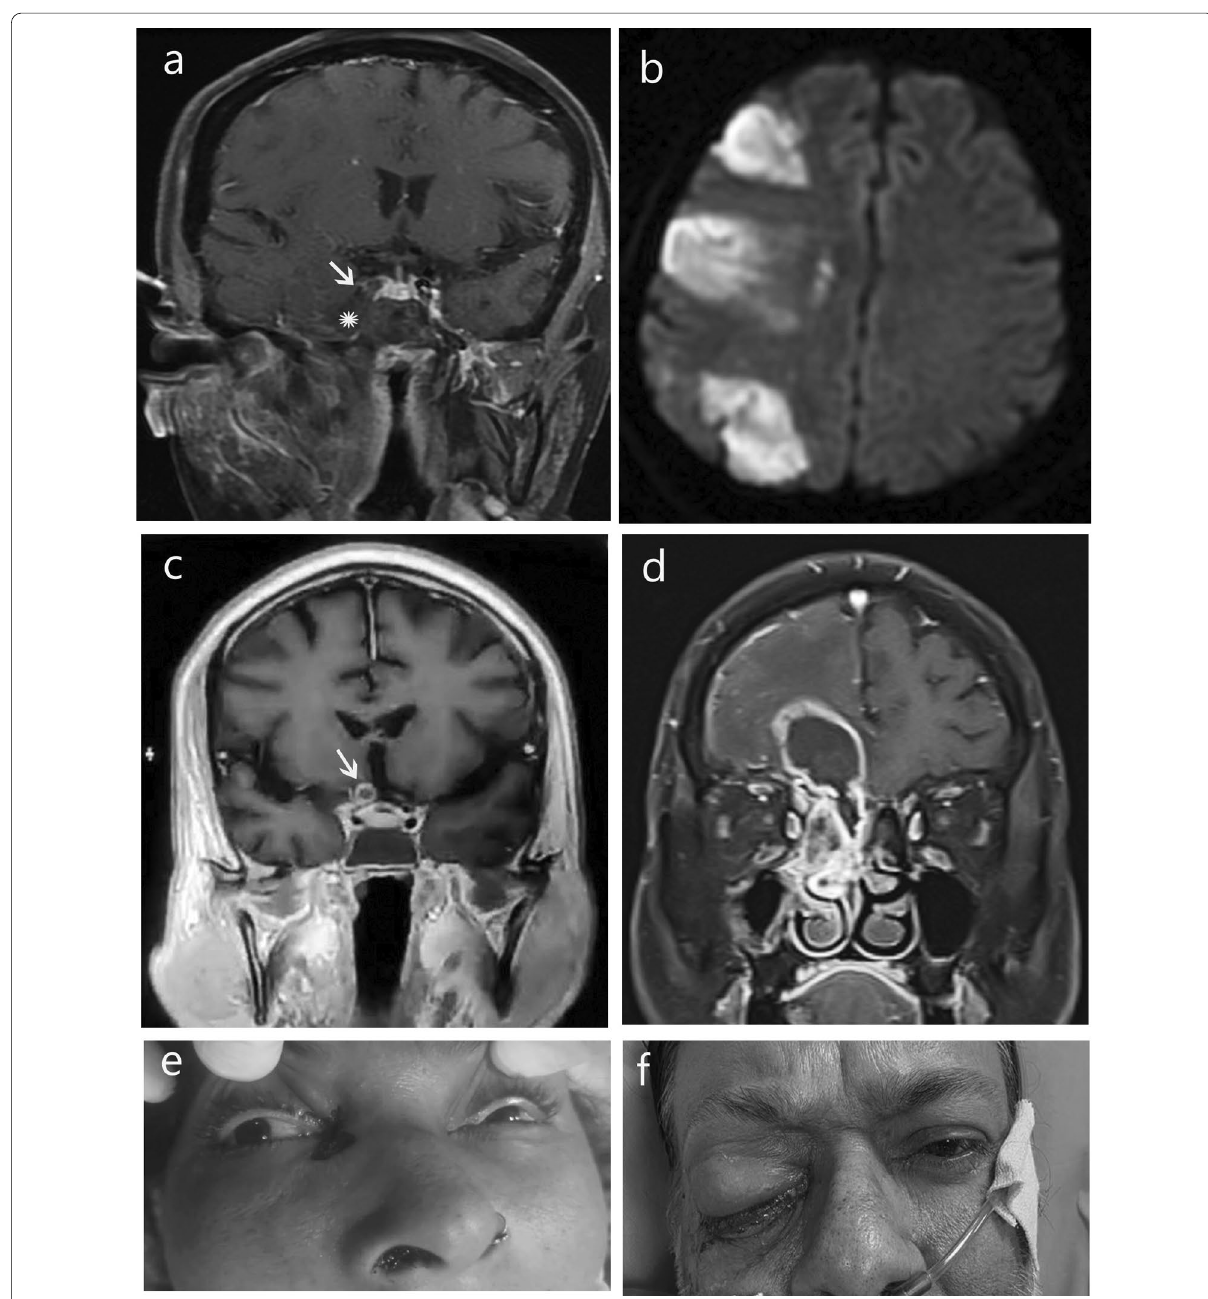
Fig. 5 Intracerebral and vascular complications. a Non-enhancing soft tissue replacing right cavernous sinus (*) with loss of flow void in internal carotid artery (arrow), enhancing soft tissue inflammation in temporal and infratemporal fossa. b DWI showing restricted diffusion in multiple water shed infarcts. c Enhancing intracerebral optic nerve (arrow) on right side. d Cribriform plate erosion and ethmoidal mucosal thickening with basifrontal abscess. e Eschar at right medial canthus and nasal opening. f Proptosis and chemosis of right upper